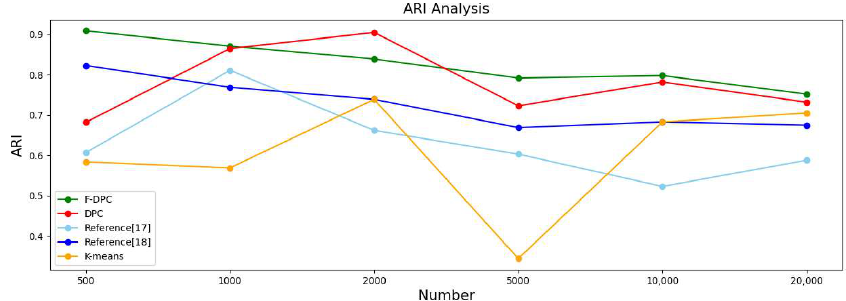
Figure 16. Line chart of evaluation index ARI [17,18].